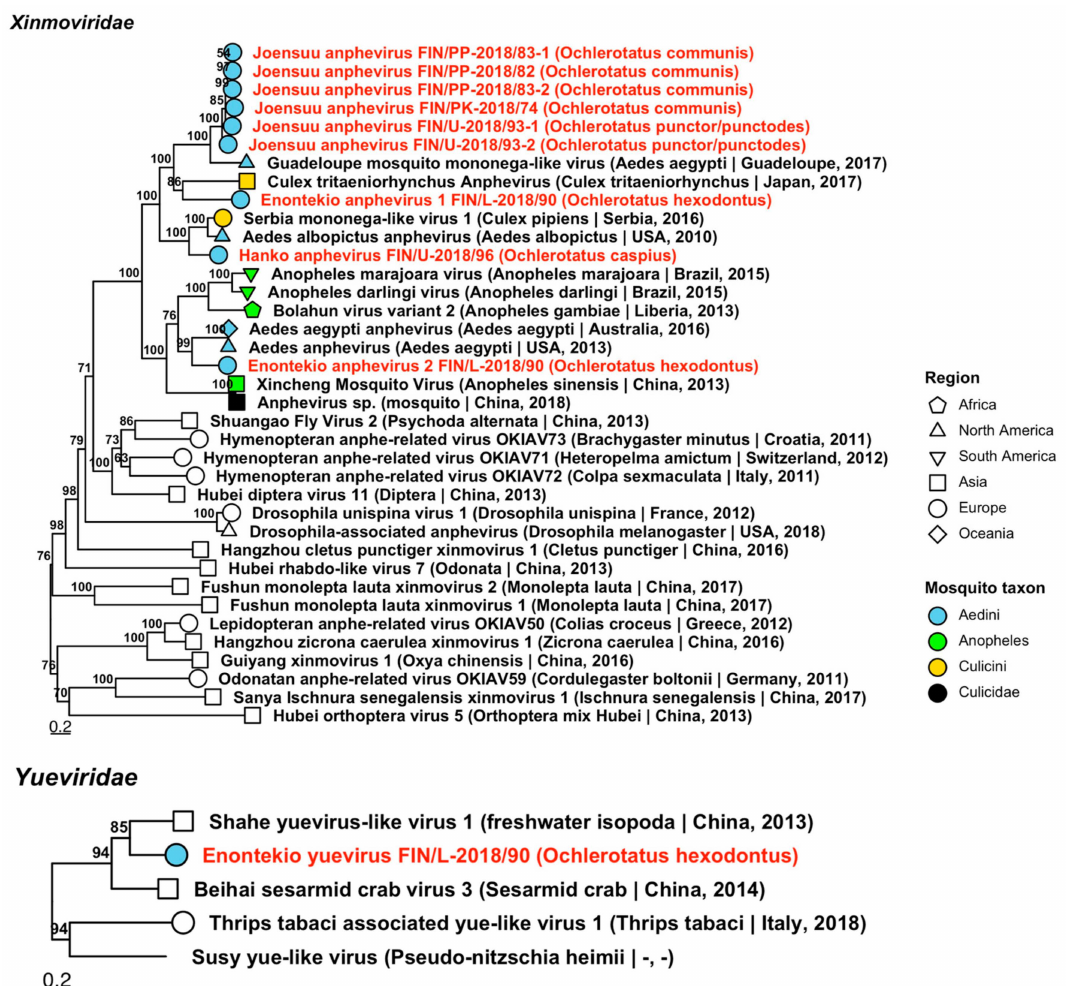
Figure 15. Maximum likelihood trees of Xinmoviridae and Yueviridae . Tentative novel viruses are dis- played in red and the mosquito species from which they were derived are in parentheses. Sequences from GenBank are black and display the following information after the virus or species name: “(sam- pled organism(s)|collection country, collection year)”. Tip colours represent the tribe (Culicinae) or genus (Anophelinae) of mosquito from which viruses were obtained. Tip shape represents the continent or region from which the specimens were collected. Trees were constructed from amino acid sequences of virus polymerases >1000 nt, aligned with MAFFT and computed with IQ-TREE2 using ModelFinder and 1000